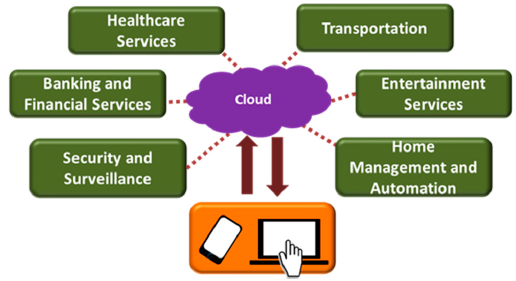
Figure 3. Applications of the Internet of Things (IoT).